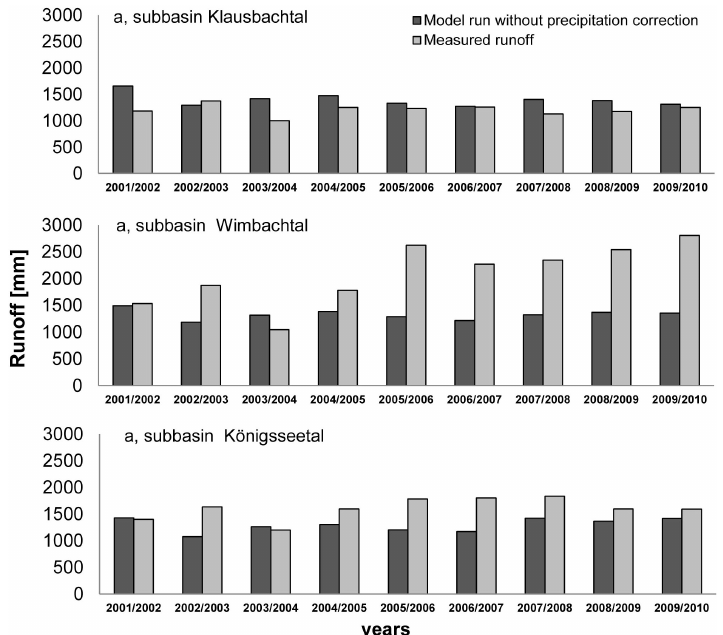
Fig. 7. Annual sums of modeled and measured discharge subbasins Klausbachtal, Wimbachtal and K¨onigsseetal before ANN correction.